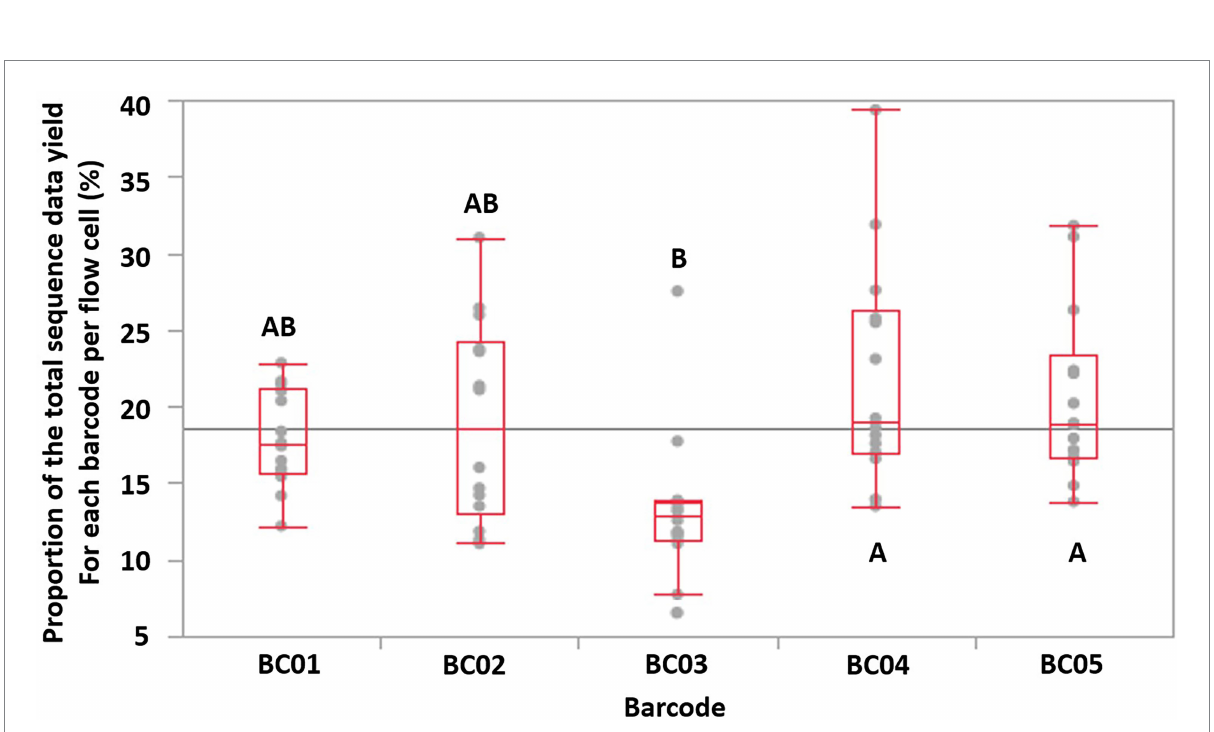
FIGURE 3 The proportion of the total sequence data yield for each barcode (labeled as BC01-BC05) per flow cell is shown as a single dot. The maximum/minimum (excluding outliers), 75, 50, and 25% quantile data yield of a barcode of each flow cell are labeled with red lines. Based on Tukey HSD test, barcodes that does not share the same letters were significantly different ( p -value < 0.05, overall ANOVA p - value = 0.0019).